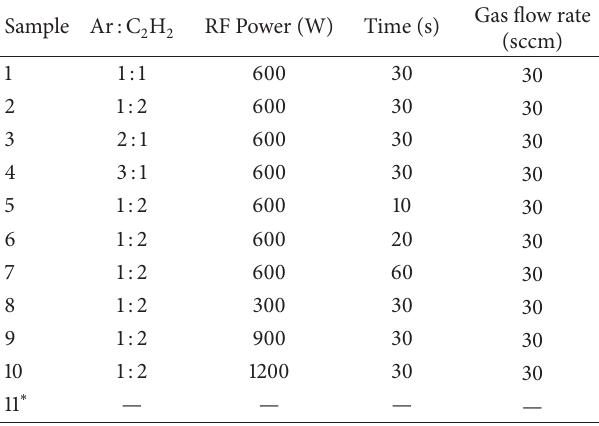
Table 1: Deposition process